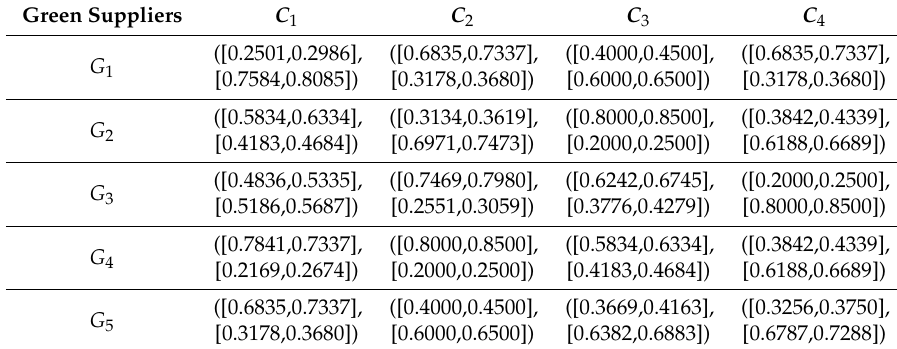
Table 4. Subgroup evaluation matrix R 2 .